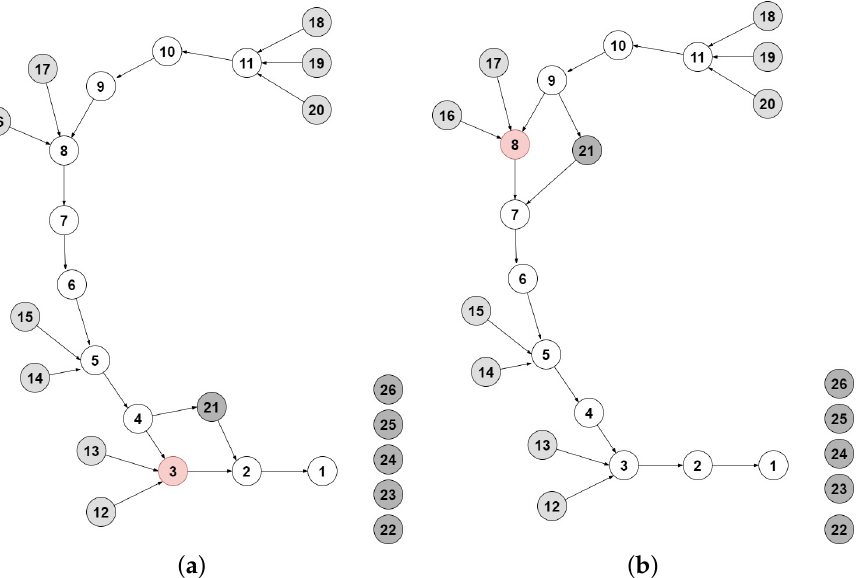
Figure 7. Scenario with reuse. ( a ) First Congestion, ( b ) Second